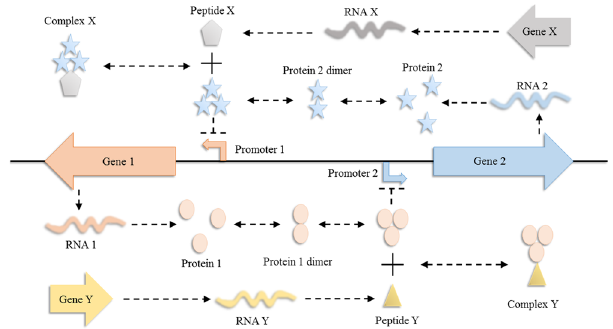
Figure 1. Reaction networks of the systems with bistability. ( a ) The mutually inhibitory network is one of the canonical motifs of genetic toggle switches, where one regulatory protein, P1 or P2, represses the expression of the gene encoding the other regulatory protein, P2 or P1. The subtle balance of P1 and P2 decides the binary fates. A cell stays at the state with either high expression of P1 or P2. There are two inhibitors, peptides X and Y, are ligands to P2 and P1. The binding of the inhibitor removes the repression of regulatory proteins. In other words, peptides X favors the expression of gene